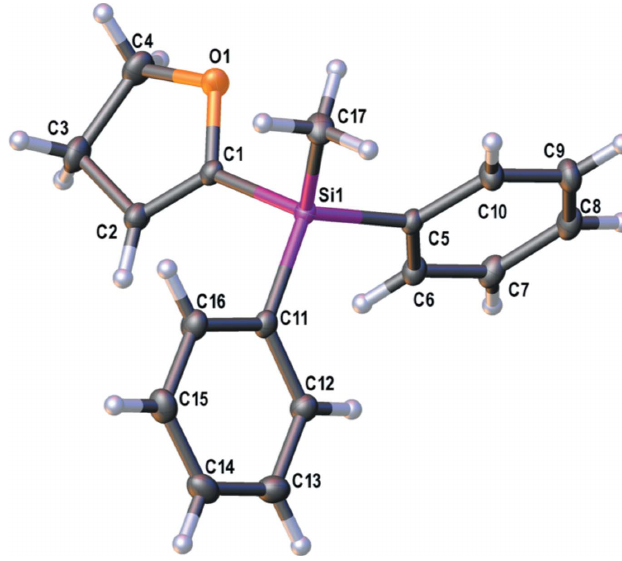
Figure 2 The molecular structure of compound 2 with displacement ellipsoids drawn at the 50% probability level.